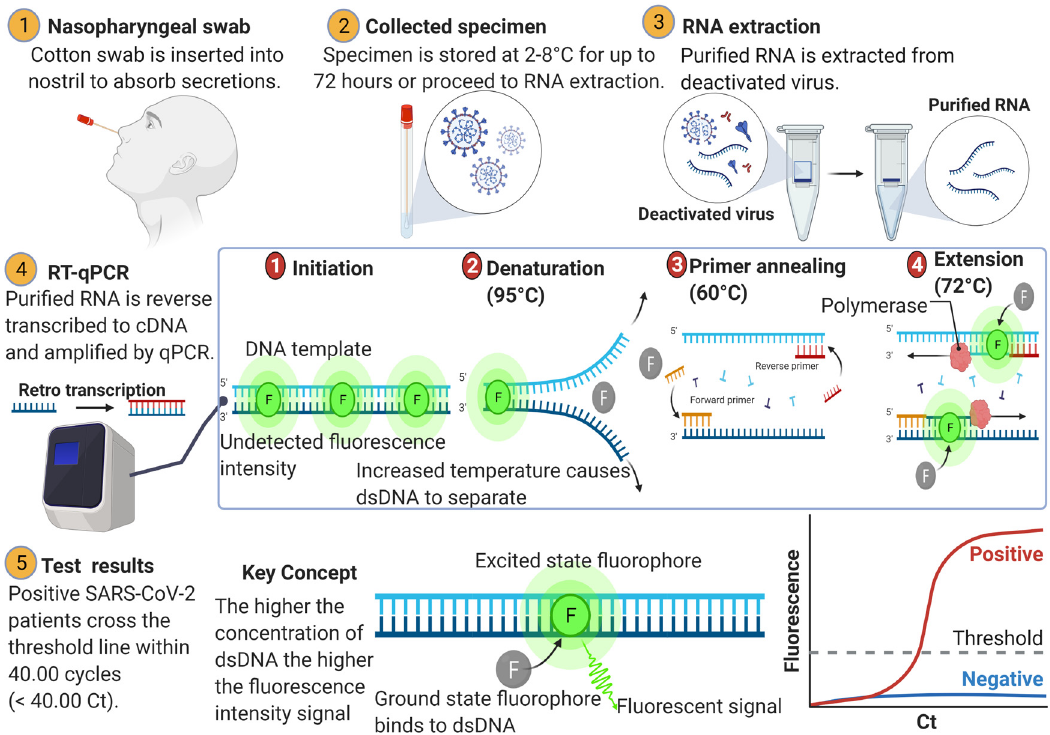
Figure 3: The diagnostic steps in PCR test for the COVID - 19 detection. Procedures include the collection of samples and viral RNA extraction. By reverse transcription process, cDNA will be generated to obtain the ampli fi cation plot. A fl uorescent signal is readily used to detect the viral cDNA.